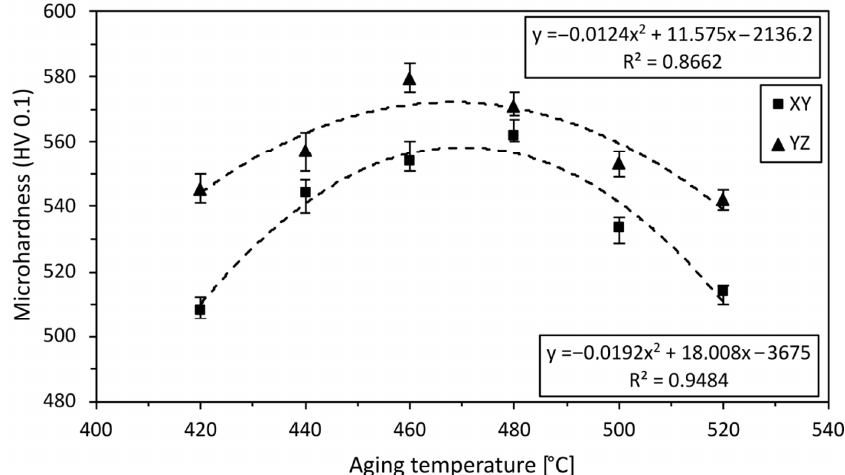
Figure 3. Dependence of Vickers microhardness on aging temperature (the microhardness is depicted in the XY and YZ planes).